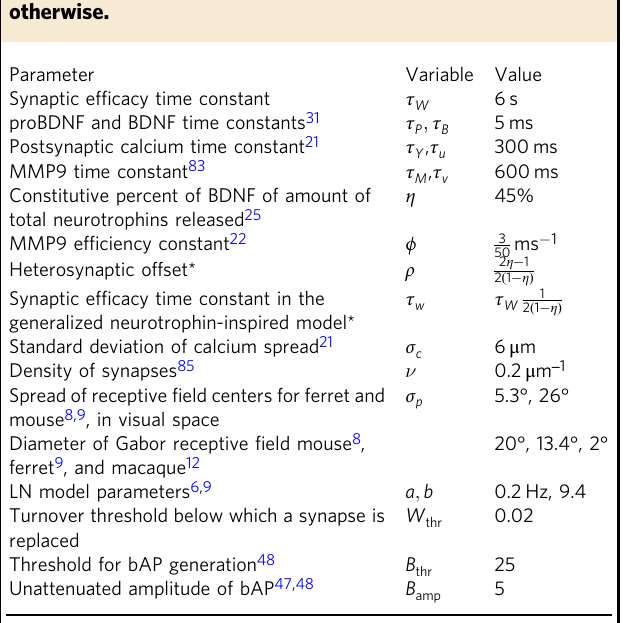
Citations indicate a free parameter fi tted to experimental data. *Indicates a parameter that is derived from the other